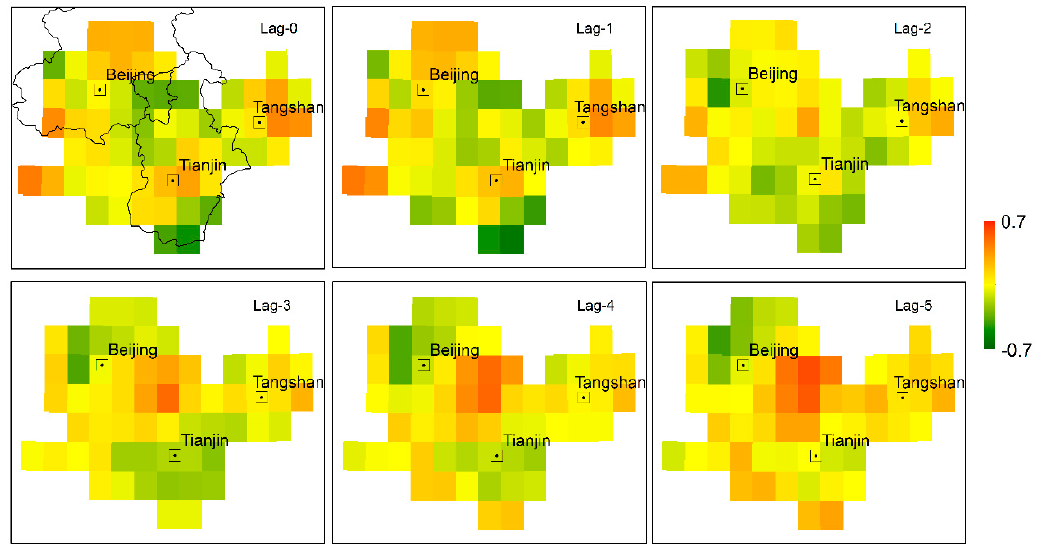
Figure 10. 0–5-month lag correlation fields between UIEP and Southern Oscillation Index (SOI) in Figure 10. 0–5 ‐ month lag correlation fields between UIEP and Southern Oscillation Index ( SOI) in ROI.